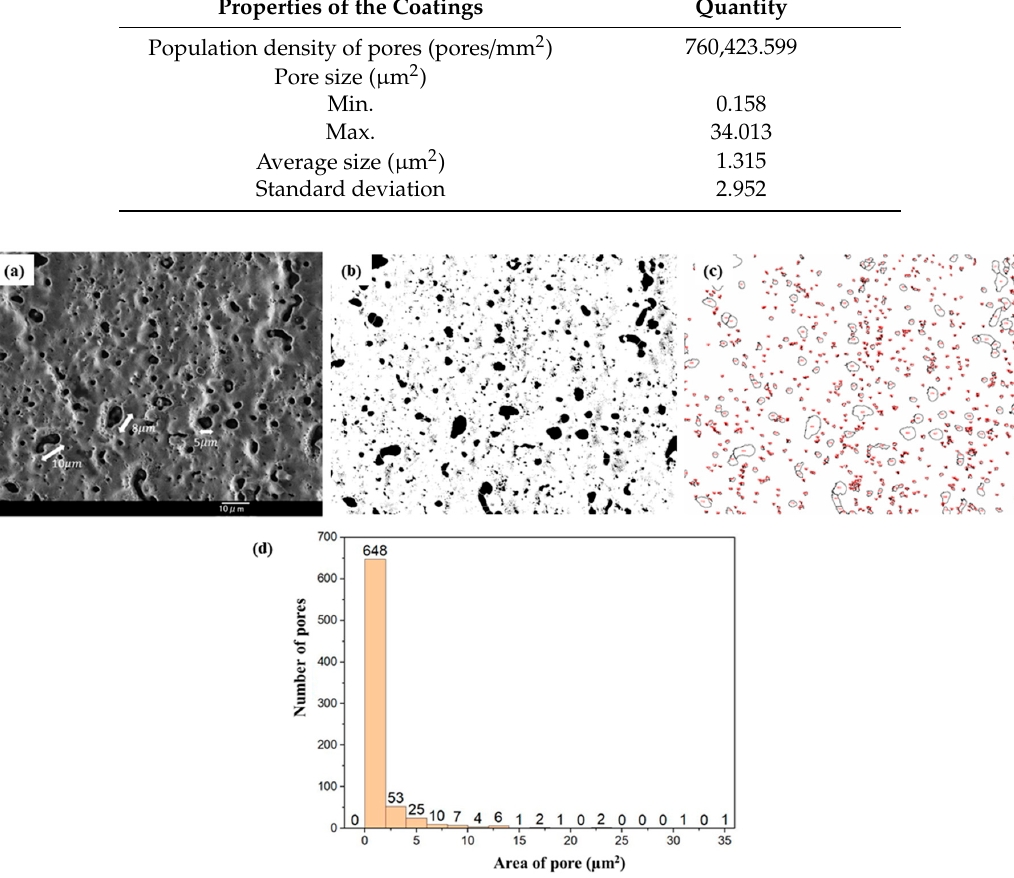
Figure 6. Crack formation around the pores on the coating surface. The presence of crooked lines at the coating/substrate interface resulted from the dissolution of the substrate in the early stage of the PEO process [40]. A typical PEO coating always comprises two particular layers (as mentioned before), namely the inner layer and outer layer where inhomogeneous pores and defects are spread on both layers. The inner layer is well adhered, less perforated, and has better mechanical properties compared to the outer layer. Then, the extent of connected porosity can be observed at the cross-section, as shown in Figure 7a,b. The total thickness of the coating surface varied in the range of 5–9 µm. The thickness of the coating was measured at ten distinct points, and the average coating thickness was calculated from those points; thereby, the average coating thickness was 7.89 µm with a standard deviation of 0.46. It appears that the cracks on the outer layer may be associated with the grinding process of the cross-section sample for SEM analysis and proving that the outer layer is flimsy and not dense. According to the Pilling–Bedworth ratio (P–B ratio), titanium’s P–B ratio is approximately 1.73, where the underlying metal is protected against further oxidation or corrosion by the passivated oxide coating; Figure 7b shows the contrary—there were open micropores on the coating layer. Repeated melting, melt-flow, and the re-solidification of the